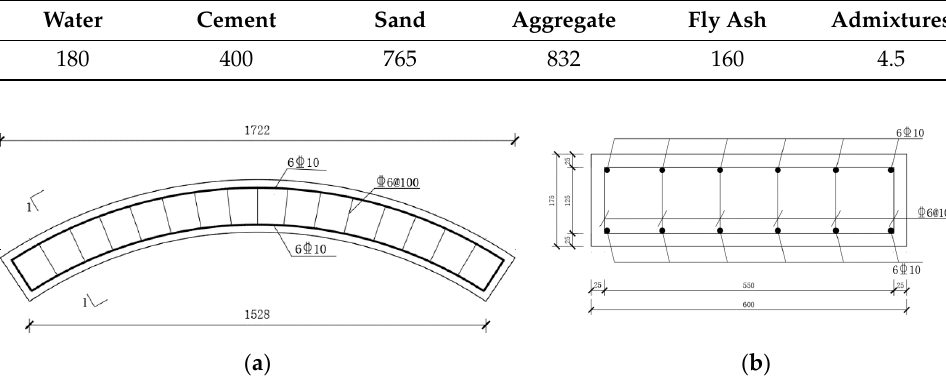
Figure 1. Size and reinforcement of test segment (Unit: mm): ( a ) Segment size and reinforcement method; ( b ) 1–1 profile view. Table 1. Mixing proportion of the concrete (kg/m 3 ).